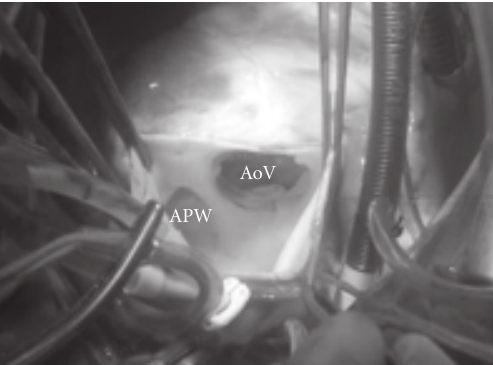
Figure 1: The aorta is opened anteriorly and parallel to the APW and the defect is exposed. APW: Aortopulmonary window: AoV: aortic